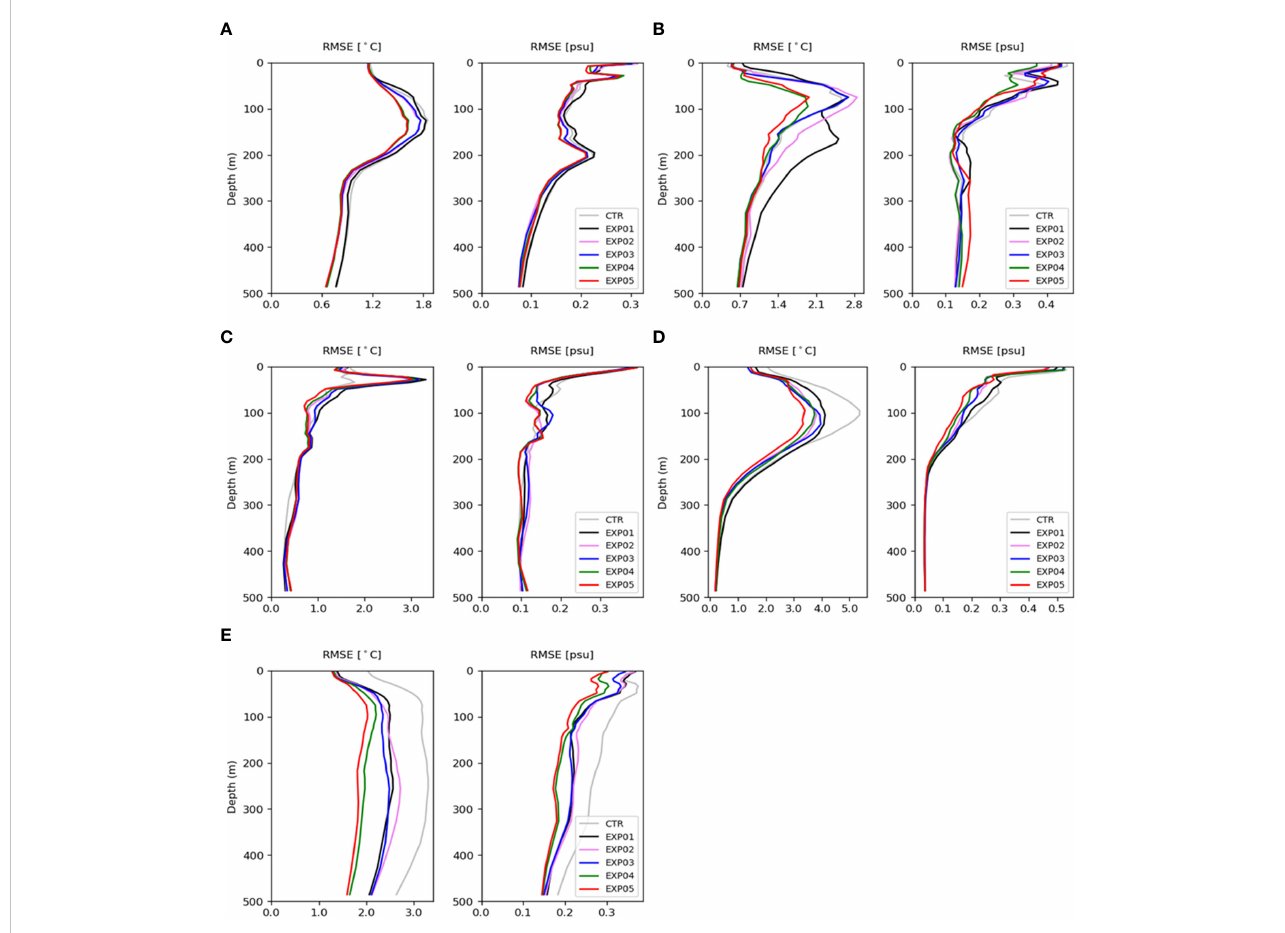
FIGURE 4 RMSE for temperature and salinity pro fi les at the region of (A) Northwestern Paci fi c (NWP), (B) South China Sea (SCS), (C) Oyashio Current (OYC), (D) East/Japan Sea (EJS), and (E) Kuroshio-Kuroshio extension (K-KE). Gray, black, violet, blue, green and red lines denote CTR and EXP01-05,